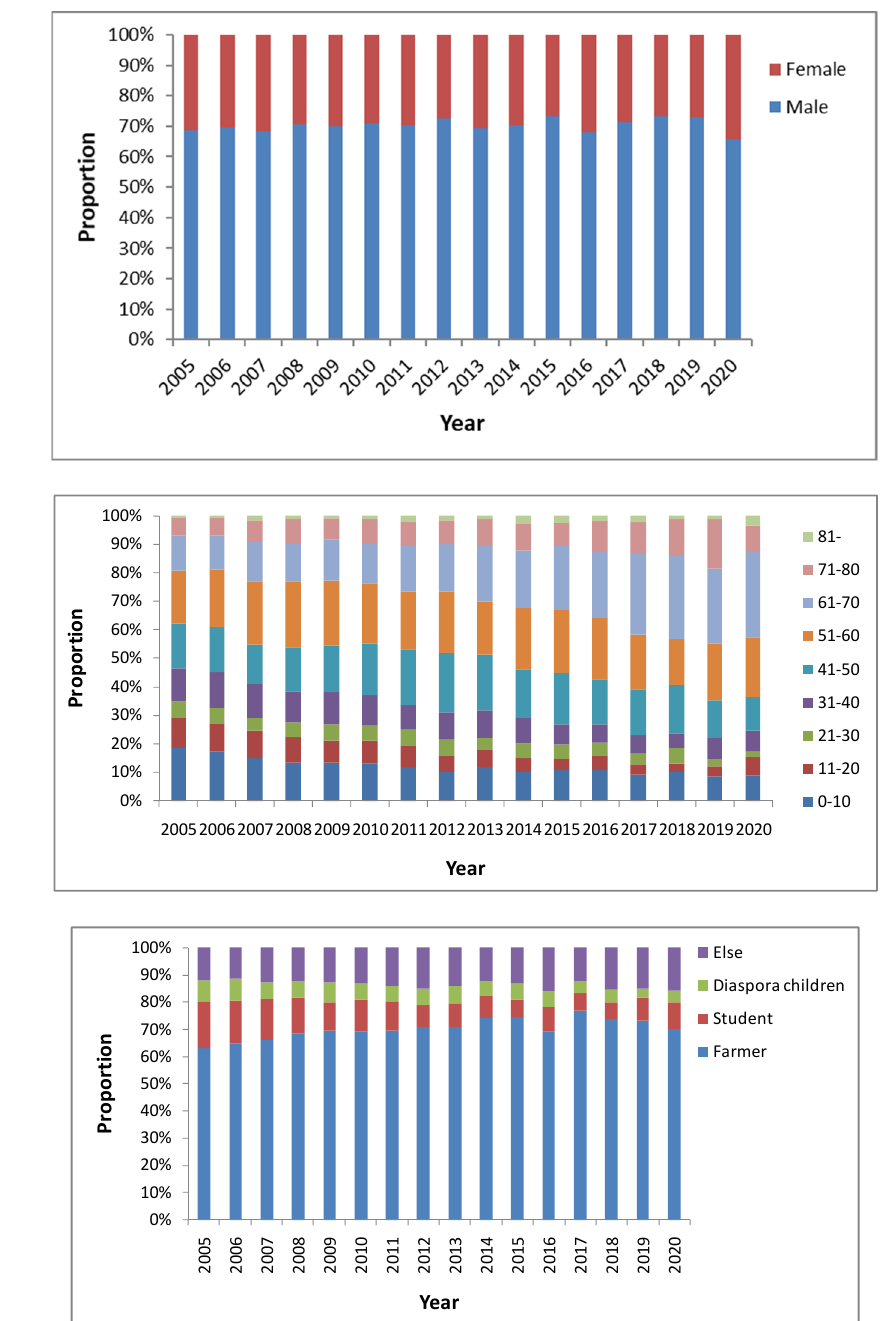
Figure 7. Time-series mapping of demographic characteristics for human rabies in mainland China, 2005–2020. ( A ) Gender. ( B ). Age. ( C ) Occupation.